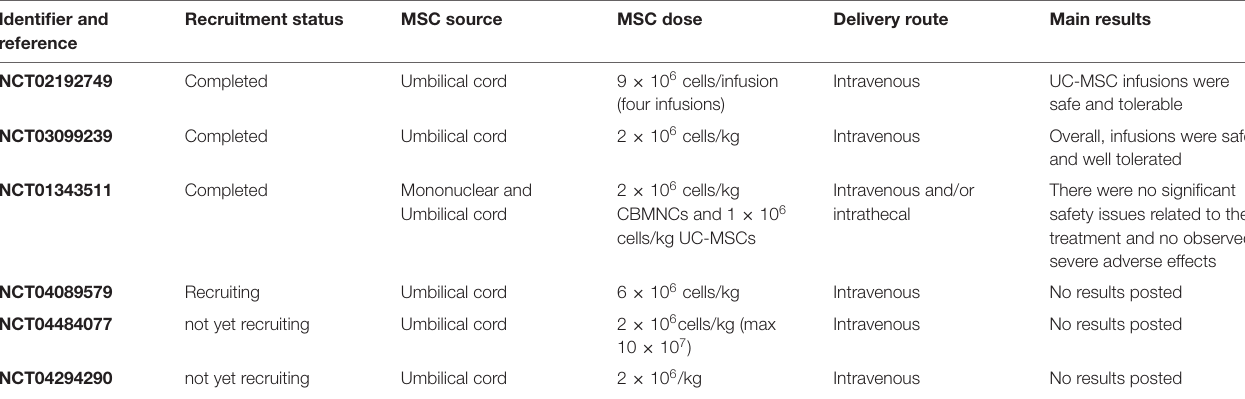
TABLE 5 | Clinical trials using mesenchymal stem/stromal cells in autism spectrum